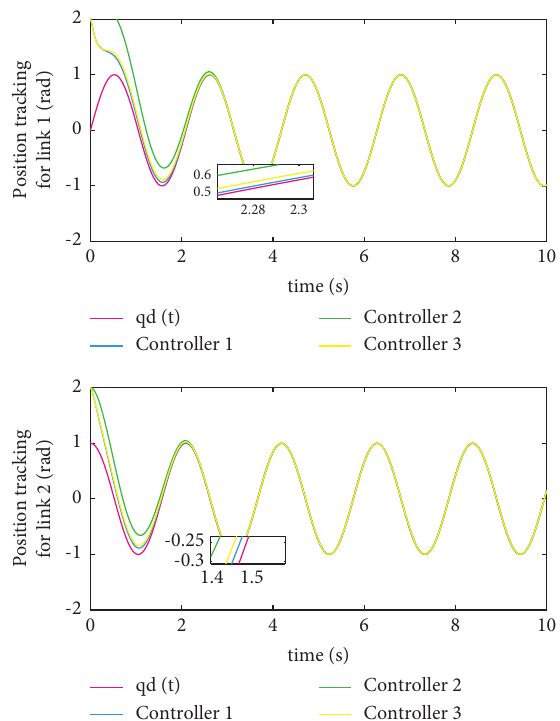
Figure 6: Comparison of manipulator trajectory tracking.